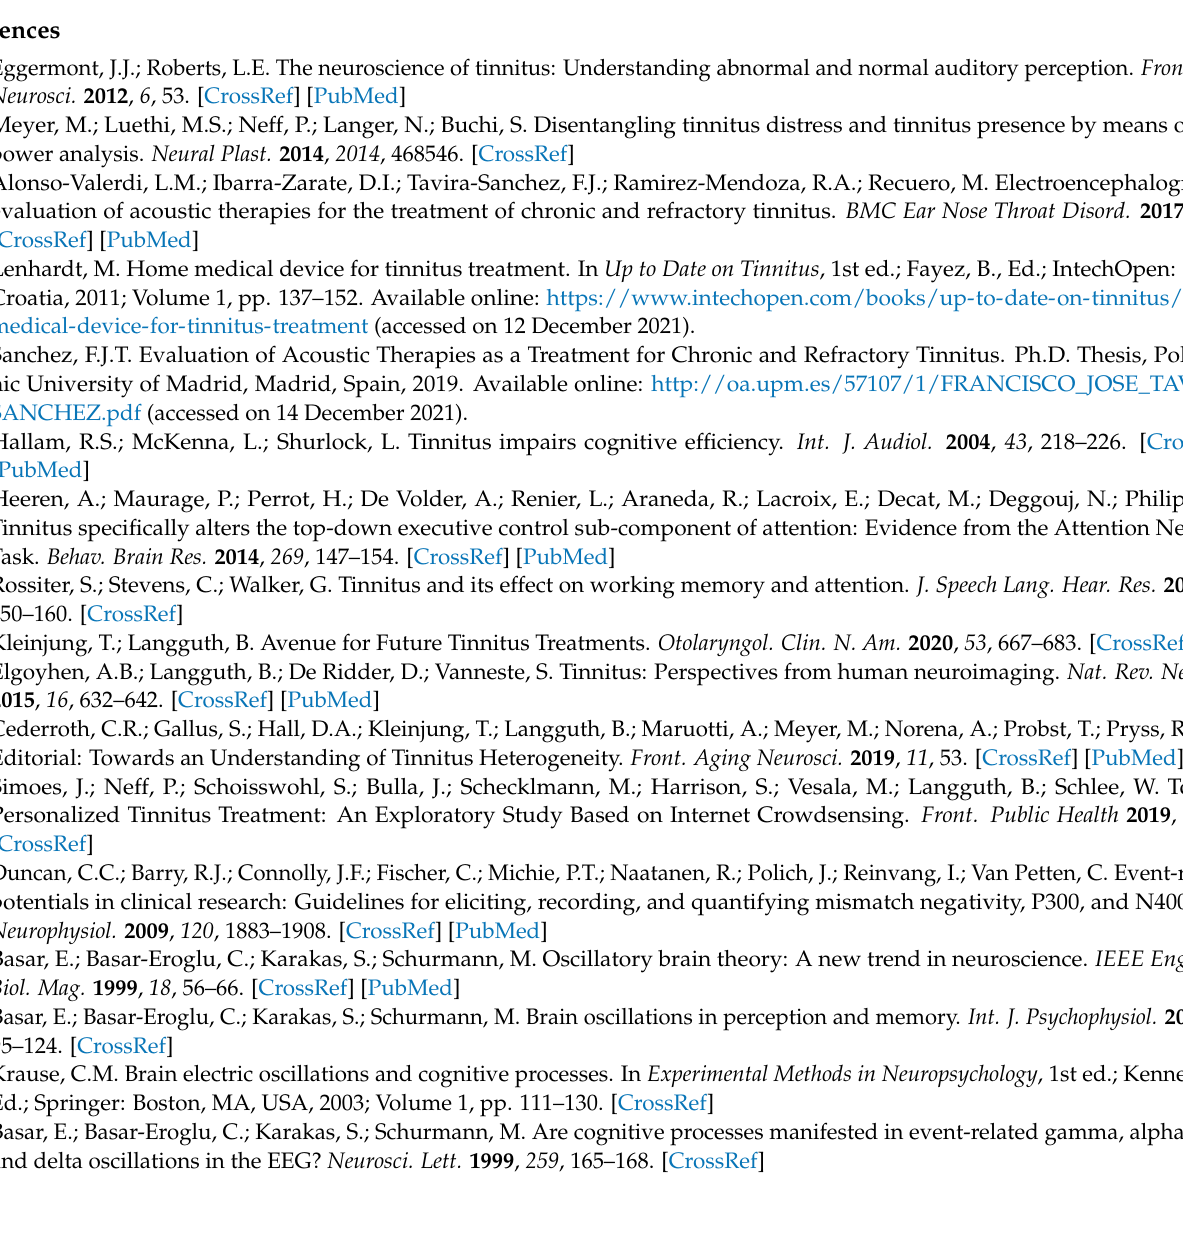
Figure A1. Training and validation curves to display the classification performance of the MobileNet-V2 model used in the current research study.